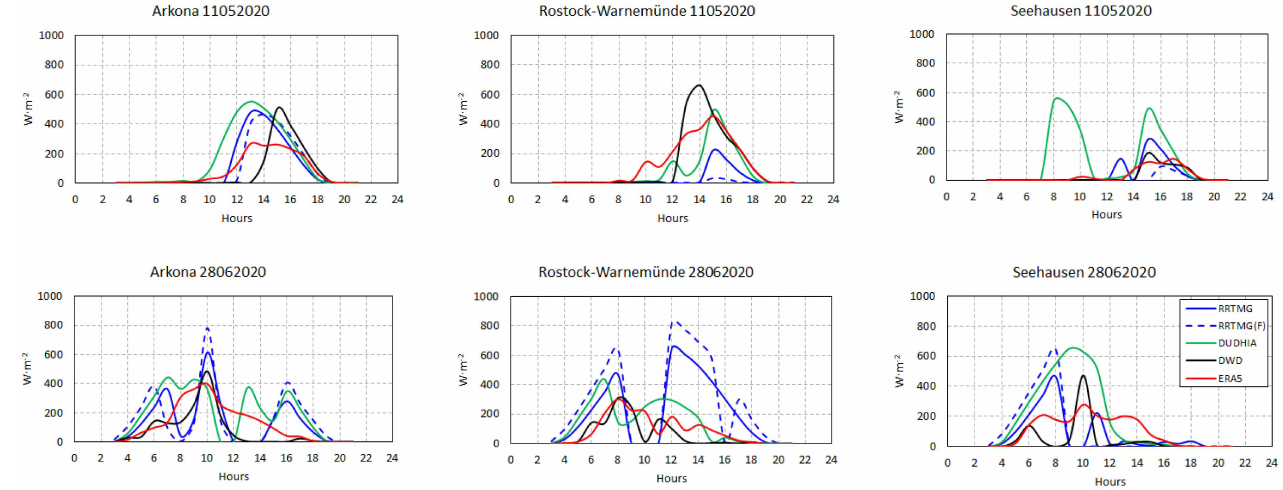
Figure 12. Diurnal distribution of the direct radiation values for the cold